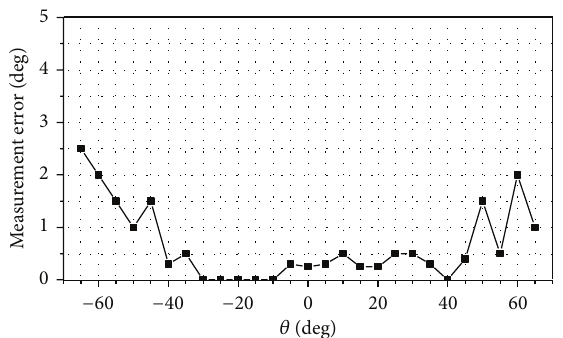
Figure 16: Measured estimation errors for a spatial field of ± 65 ∘